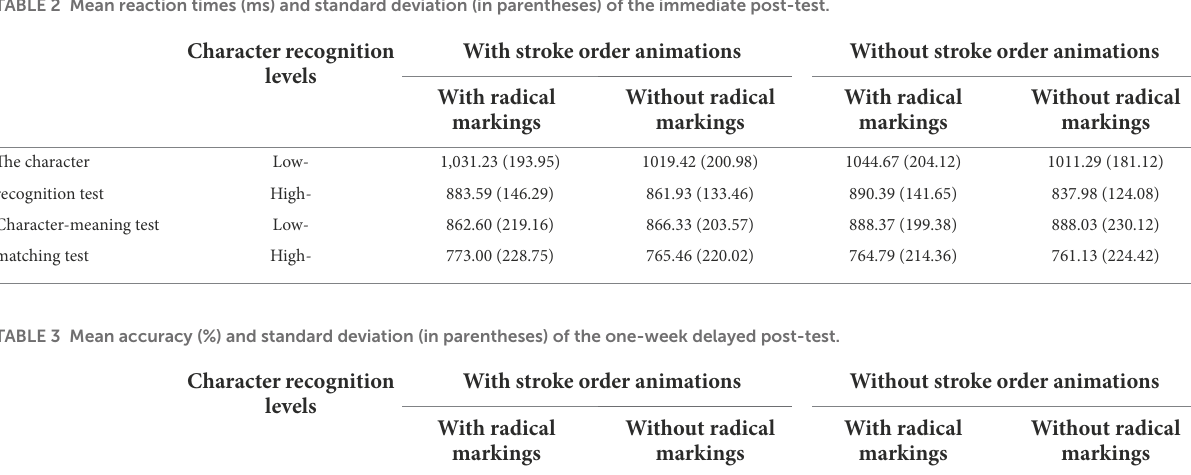
TABLE 2 Mean reaction times (ms) and standard deviation (in parentheses) of the immediate post-test.